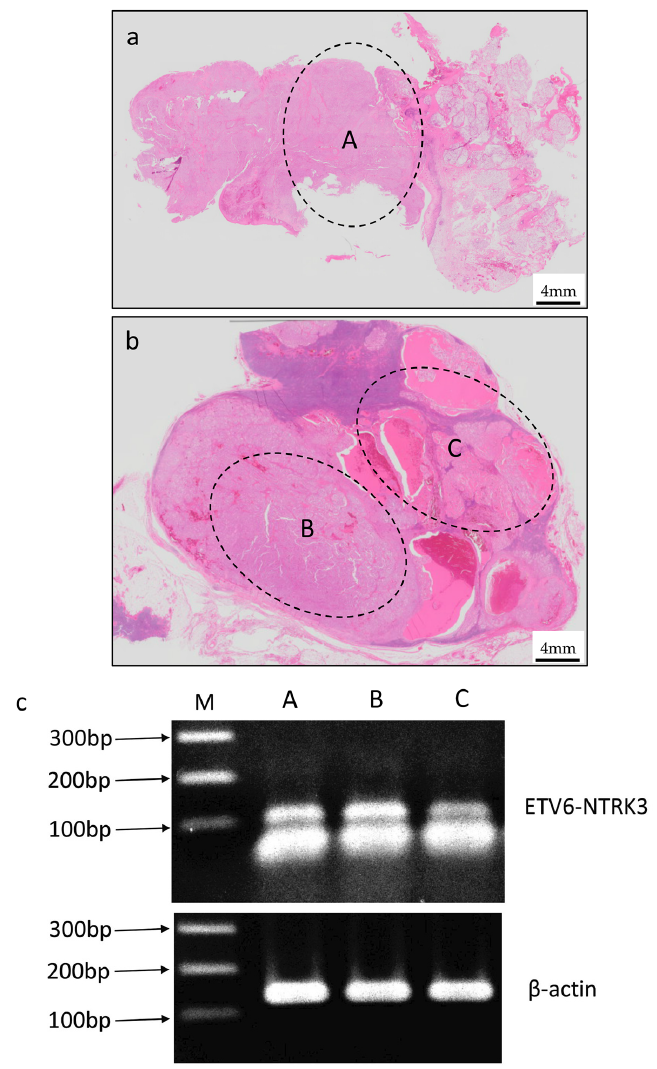
Figure 7. Expression of ETV6-NTRK3 fusion transcript in the primary lesion and the metastasis lesion by RT-PCR. ( a , b ) The tissue collection sites of primary and metastasis lesions. ( c ) ETV6-NTRK3 fusion transcript confirmed by RT-PCR. Line A was primary lesion and Line B and C were metastasis lesions.